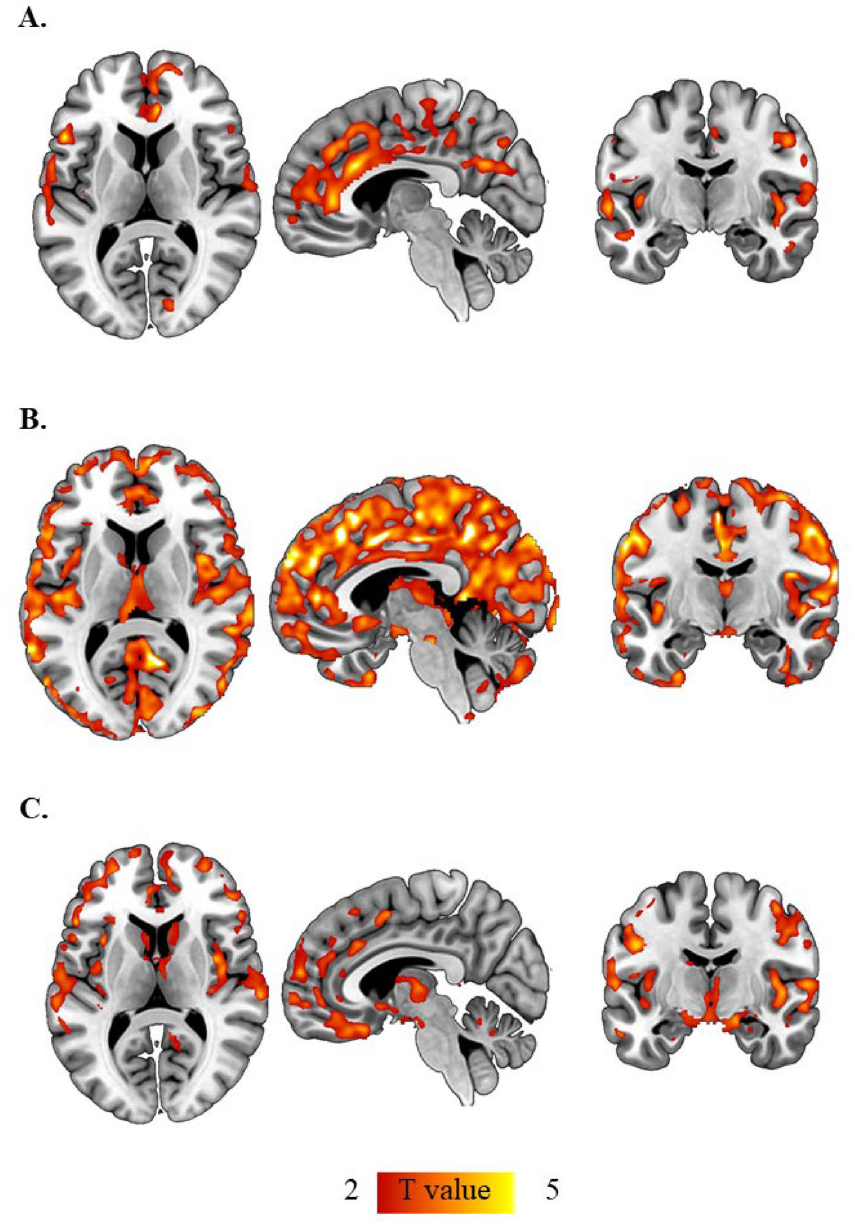
Figure 4. Plasma Neurofilament light chain correlated inversely with gray matter density in the whole dataset ( A ). This correlation was more widespread in the lean ( B ), compared to the obese ( C ) individuals. Statistical parametric mapping results ( p < 0.05, false discovery rate (FDR) corrected; extent threshold k: 9937 ( A ), extent threshold k: 1120 ( B ); Extent threshold k: 7614 ( C ), X: 5, Y: − 10, Z: 9.5). Images were created using Mango (Multi-image Analysis GUI) software, version 4.1 (http:// rii. uthsc sa. edu/